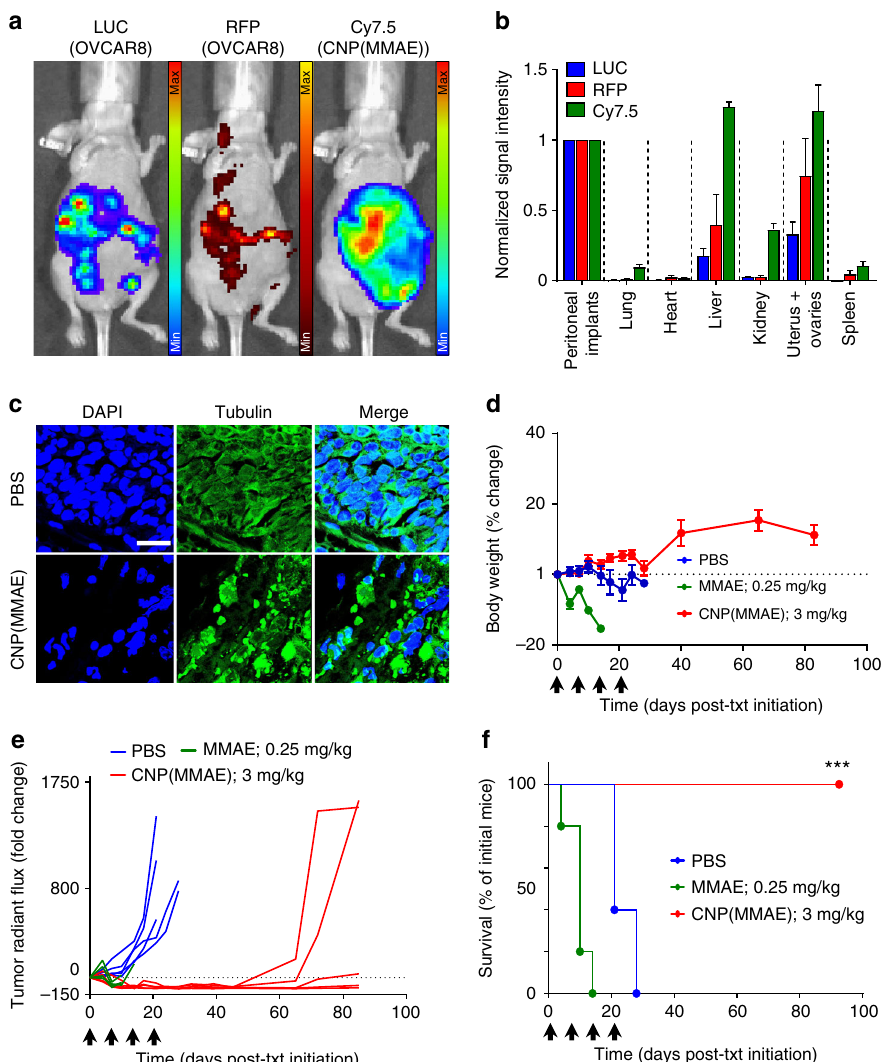
Fig. 5 On-target activity and therapeutic ef fi cacy of MMAE-conjugated nanoparticles in an orthotopic cell-line xenograft model of disseminated ovarian cancer. a Representative in vivo images of a single LUC + /RFP + OVCAR8 tumor-bearing nude mouse at 72 h after IP administration of coated, Cy7.5-labeled, and MMAE-conjugated nanoparticles (CNP(MMAE/Cy7.5)). b Ex vivo signal intensities in each organ at the time of animal sacri fi ce ( n = 3 mice/group). Signal intensity was normalized to the value measured from the intestines of each animal, which had high burdens of micrometastatic tumor foci. c Immuno fl uorescence staining for α -tubulin in OVCAR8 tumor implants excised from nude mice at 72 h after IP administration of CNP (MMAE) or PBS (control). d Changes in the body weights as compared to baseline. e Tumor burden over time as determined by changes from the baseline radiant fl ux associated with the BLI signal intensity. f Survival of OVCAR8 tumor-bearing nude mice that received ×4 weekly IP injections of CNP(MMAE) (at an equivalent dose of 3 mg/kg MMAE), free MMAE (at 0.25 mg/kg), or PBS (control treatment). The black arrows indicate the timing of each dose of treatment. The CNP(MMAE) group demonstrated a statistically signi fi cant improvement in survival as compared to mice that received either PBS and free MMAE (*** p -value < 0.001, Log-rank test)